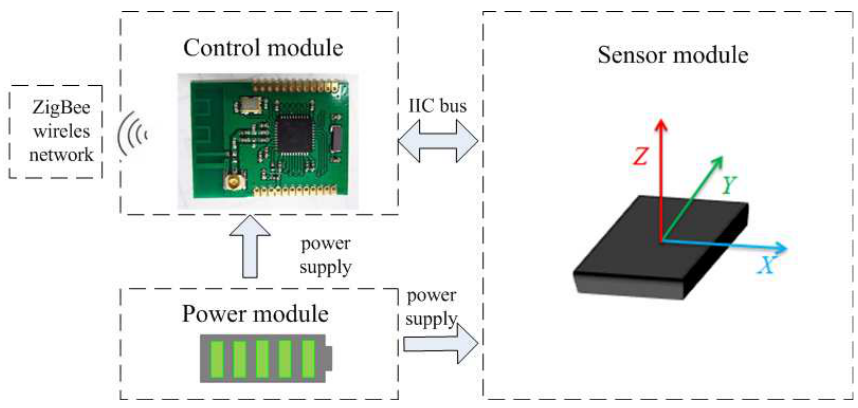
Figure 4. The structure of the sensor